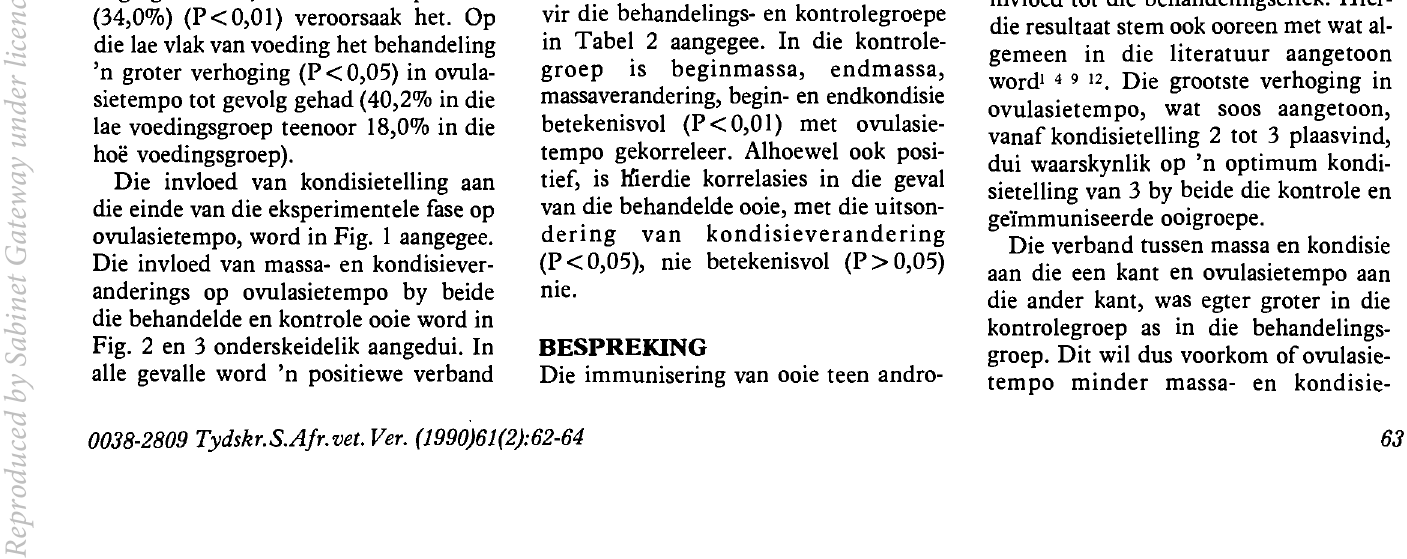
Fig. 2: Die invloed van mass aver andering op ovulasietempo by behandelde en kontrole ooie aangetoon. Die grootste verhoging in ovulasietempo vind plaas vanaf kondi sietelling 2 tot 3 (Fig. I). Hierdie verskil is egter nie betekenisvol (P > 0,05). 'n